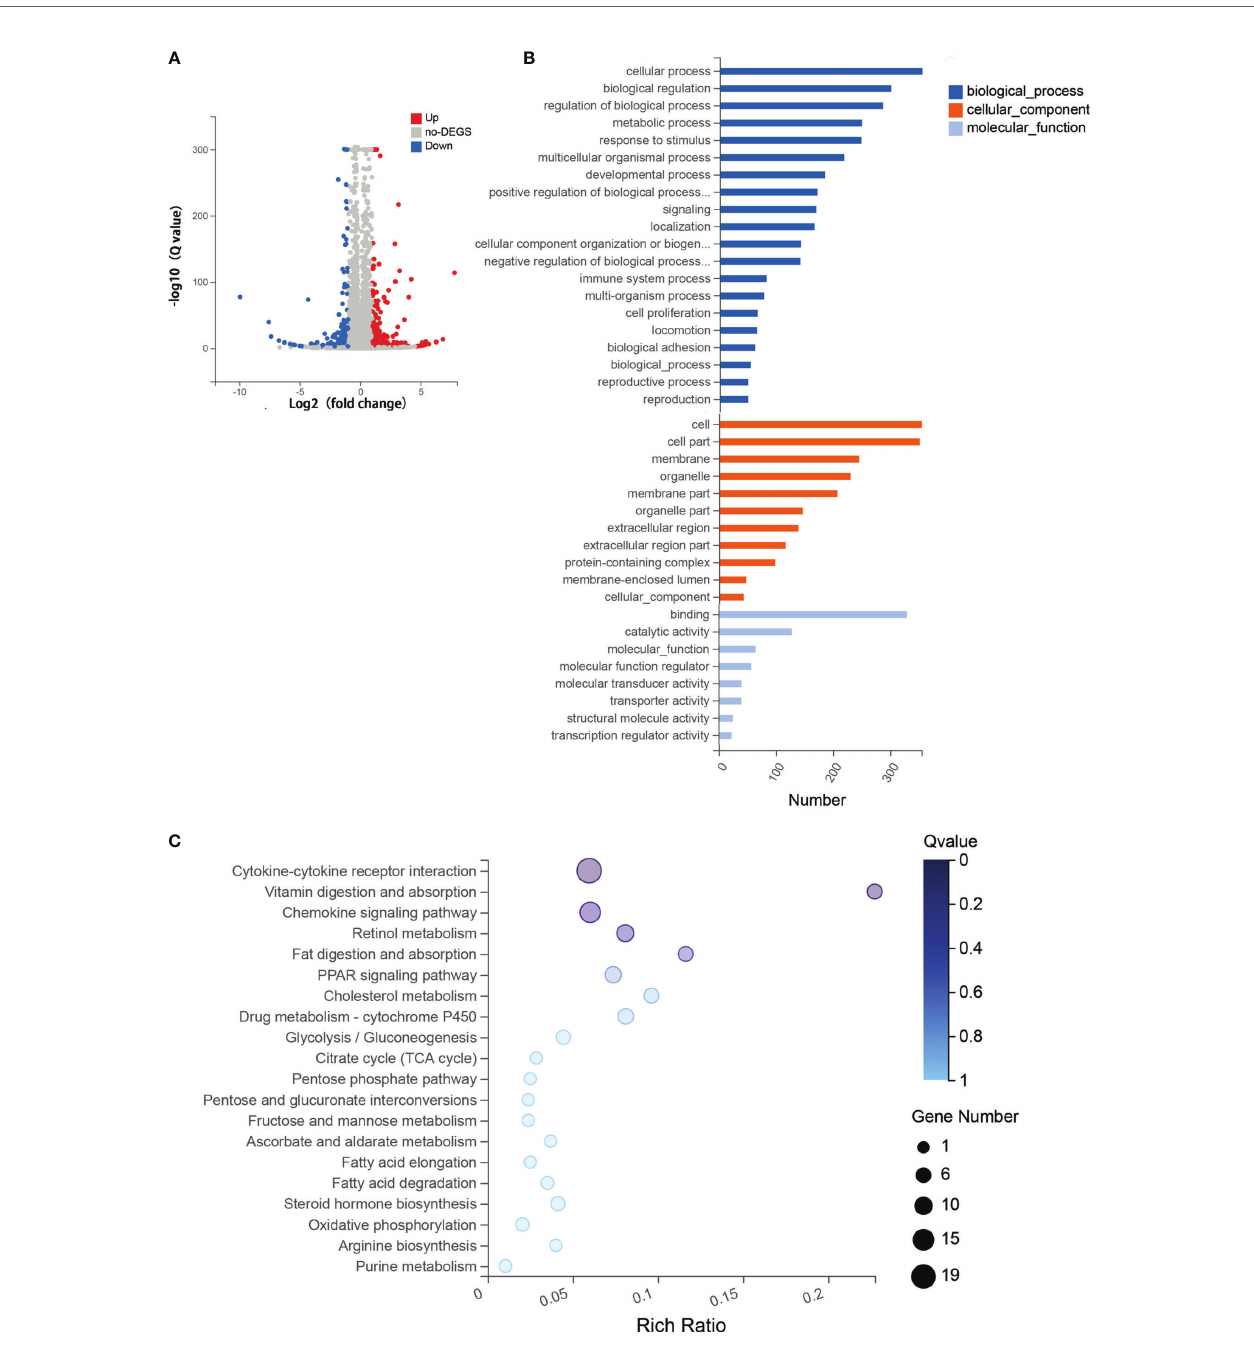
FIGURE 6 | RNA sequencing (RNA-seq) analysis for the combined therapy of azacitidine (5-Aza) and 3-deazaneplanocin (DZNep). (A) Volcano map of the differentially expressed genes (DEGs) between the control group and the combined 5-Aza and DZNep treatment group. The x -axis is the log2 scale of the fold change of gene expression [log2(5-Aza+DZNep/Control)]. The y -axis is the minus log10 scale of the adjusted p -values [log10( Q value)], indicating the signi fi cant level of expression difference. Red dots represent signi fi cantly upregulated genes with at least a twofold change, while blue dots represent signi fi cantly downregulated genes with at least a twofold change. (B) Enriched Gene Ontology (GO) terms in the DEGs between the acute graft- versus -host disease (aGvHD) group and the combined 5-Aza and DZNep treatment group. (C) Top 20 Kyoto Encyclopedia of Genes and Genomes (KEGG) enriched pathway terms in DEGs. The x -axis is the enrichment ratio (Enrichment ratio = Term candidate gene number/Term gene number). The y -axis represents the KEGG pathways. The size of the bubble indicates the number of DEGs annotated on a KEGG pathway and the color represents the enriched Q value; the darker the color, the smaller the Q value. DEG , differentially expressed